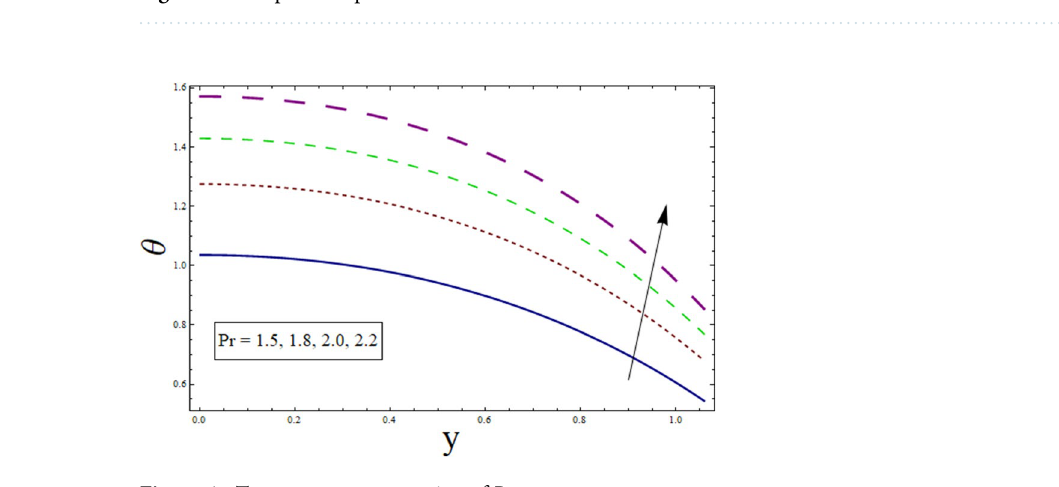
Figure 5. Temperature presentation of k .